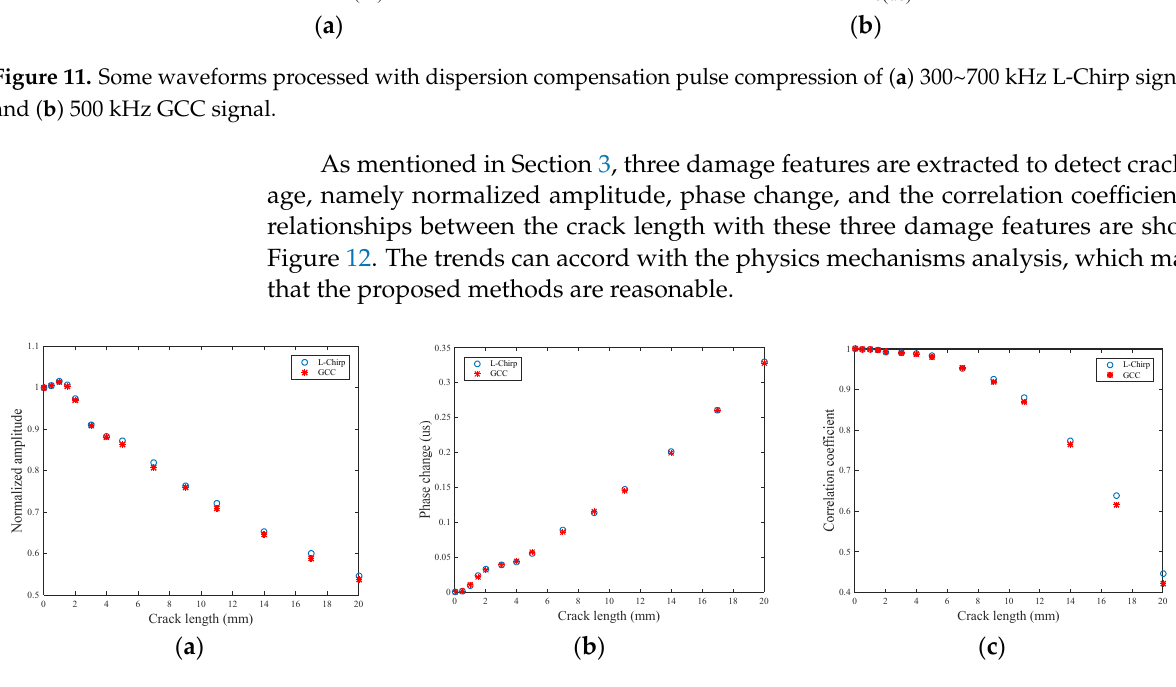
Figure 12. Damage features of the processed signal in the simulation: ( a ) normalized amplitude; ( b ) phase change; ( c ) correlation coefficient.